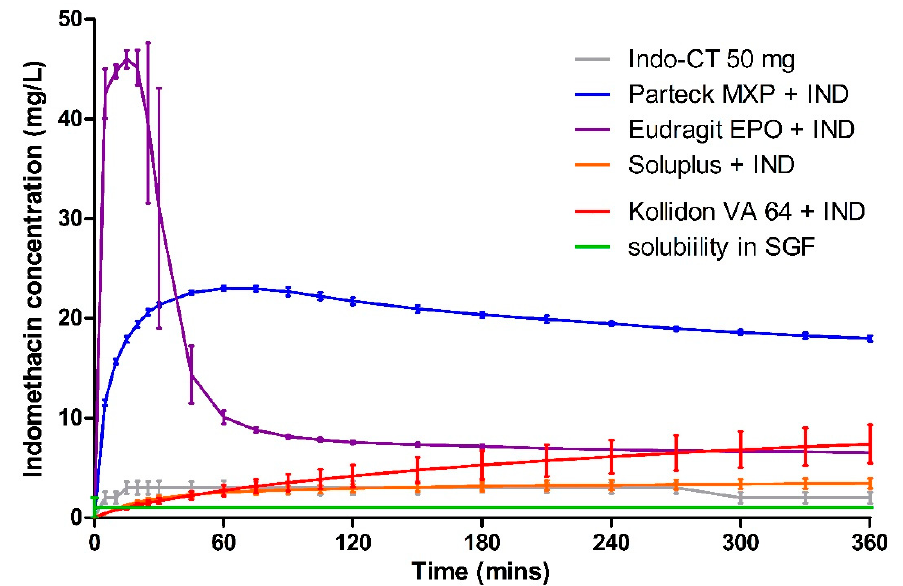
Figure 8. Dissolution testing for milled HME material in simulated gastric fluid.